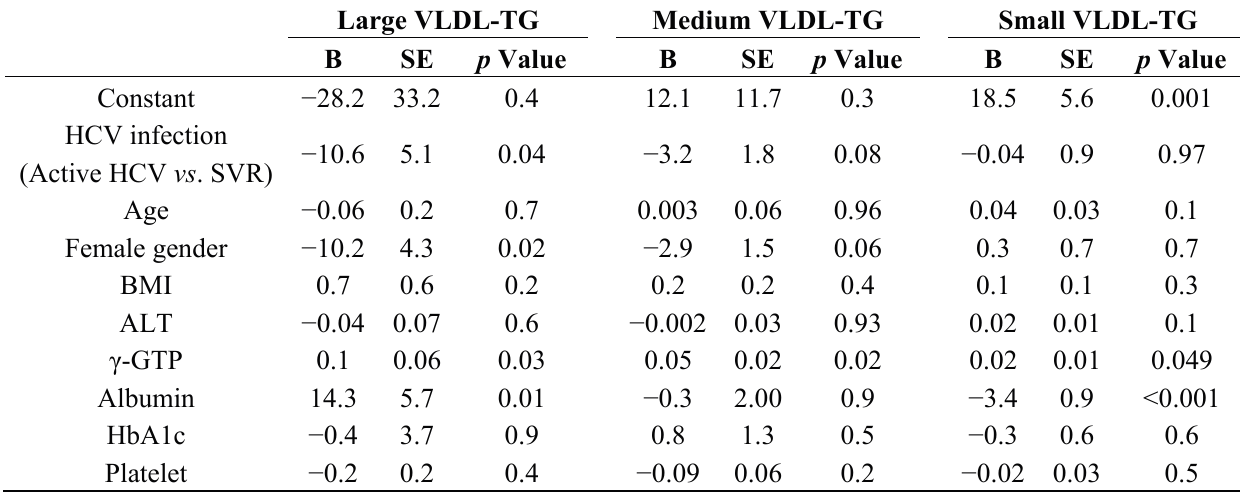
Table 3. Significance of active chronic HCV infection in the distribution of TG in the three VLDL sub-fractions analyzed by multiple regression